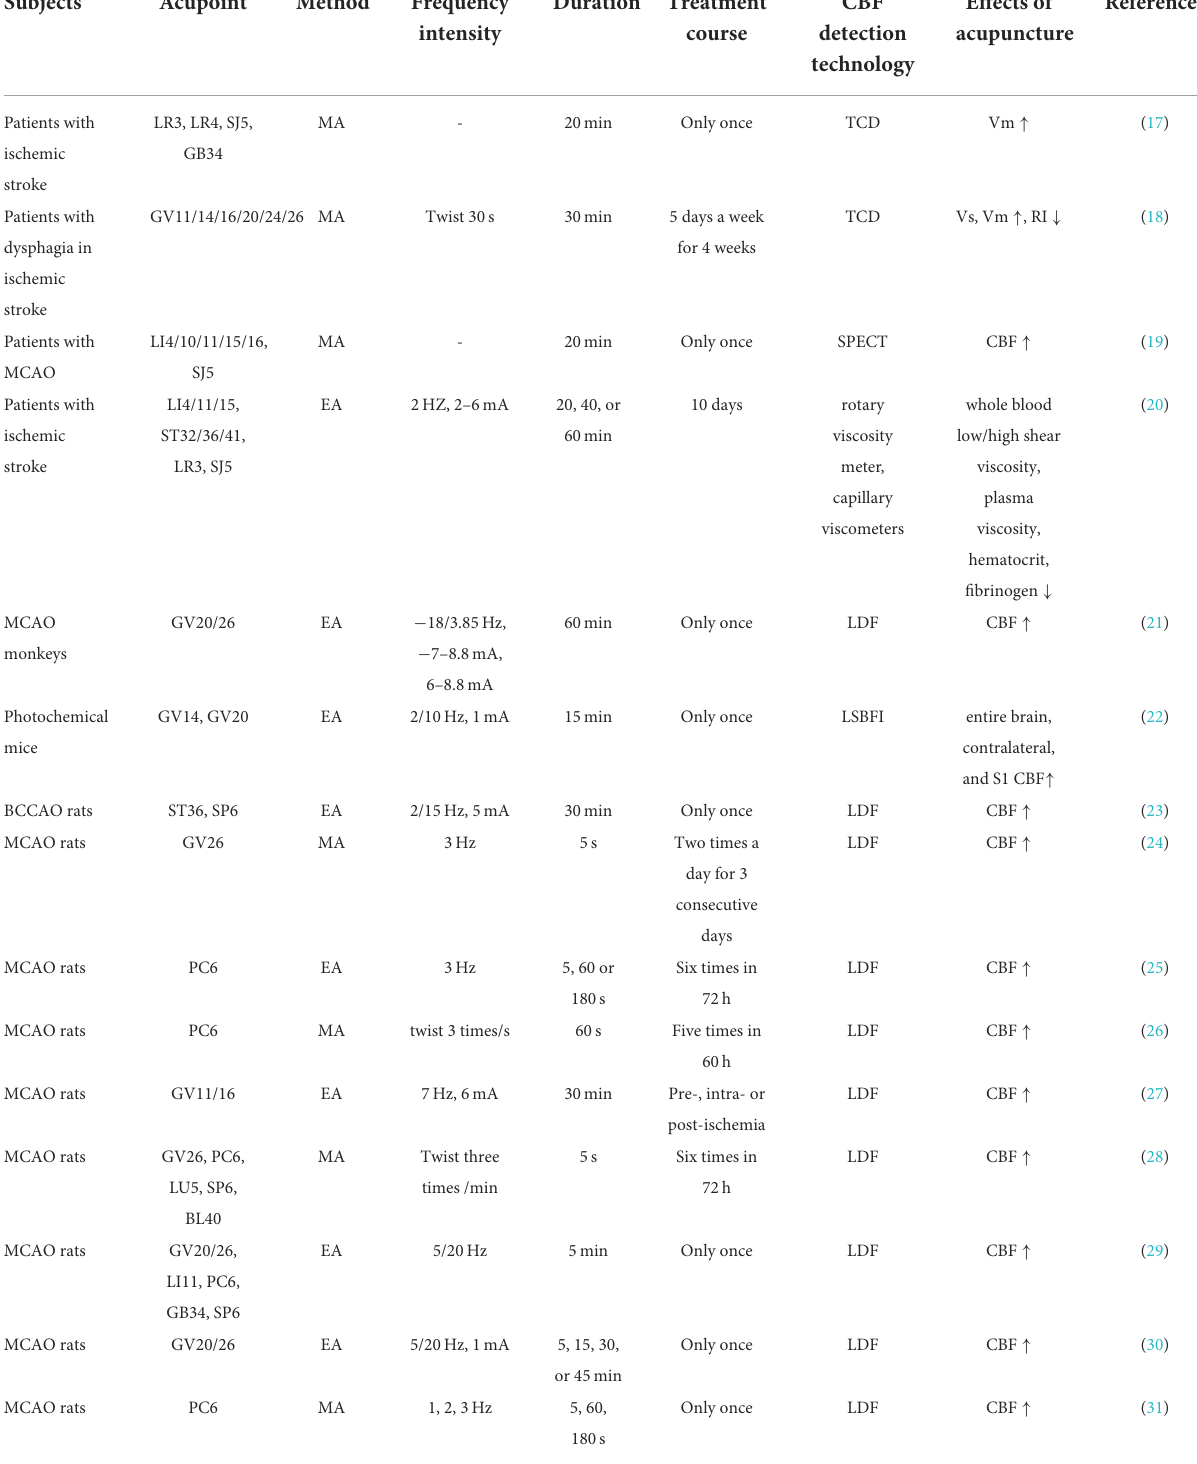
TABLE 1 Acupuncture modulates cerebral